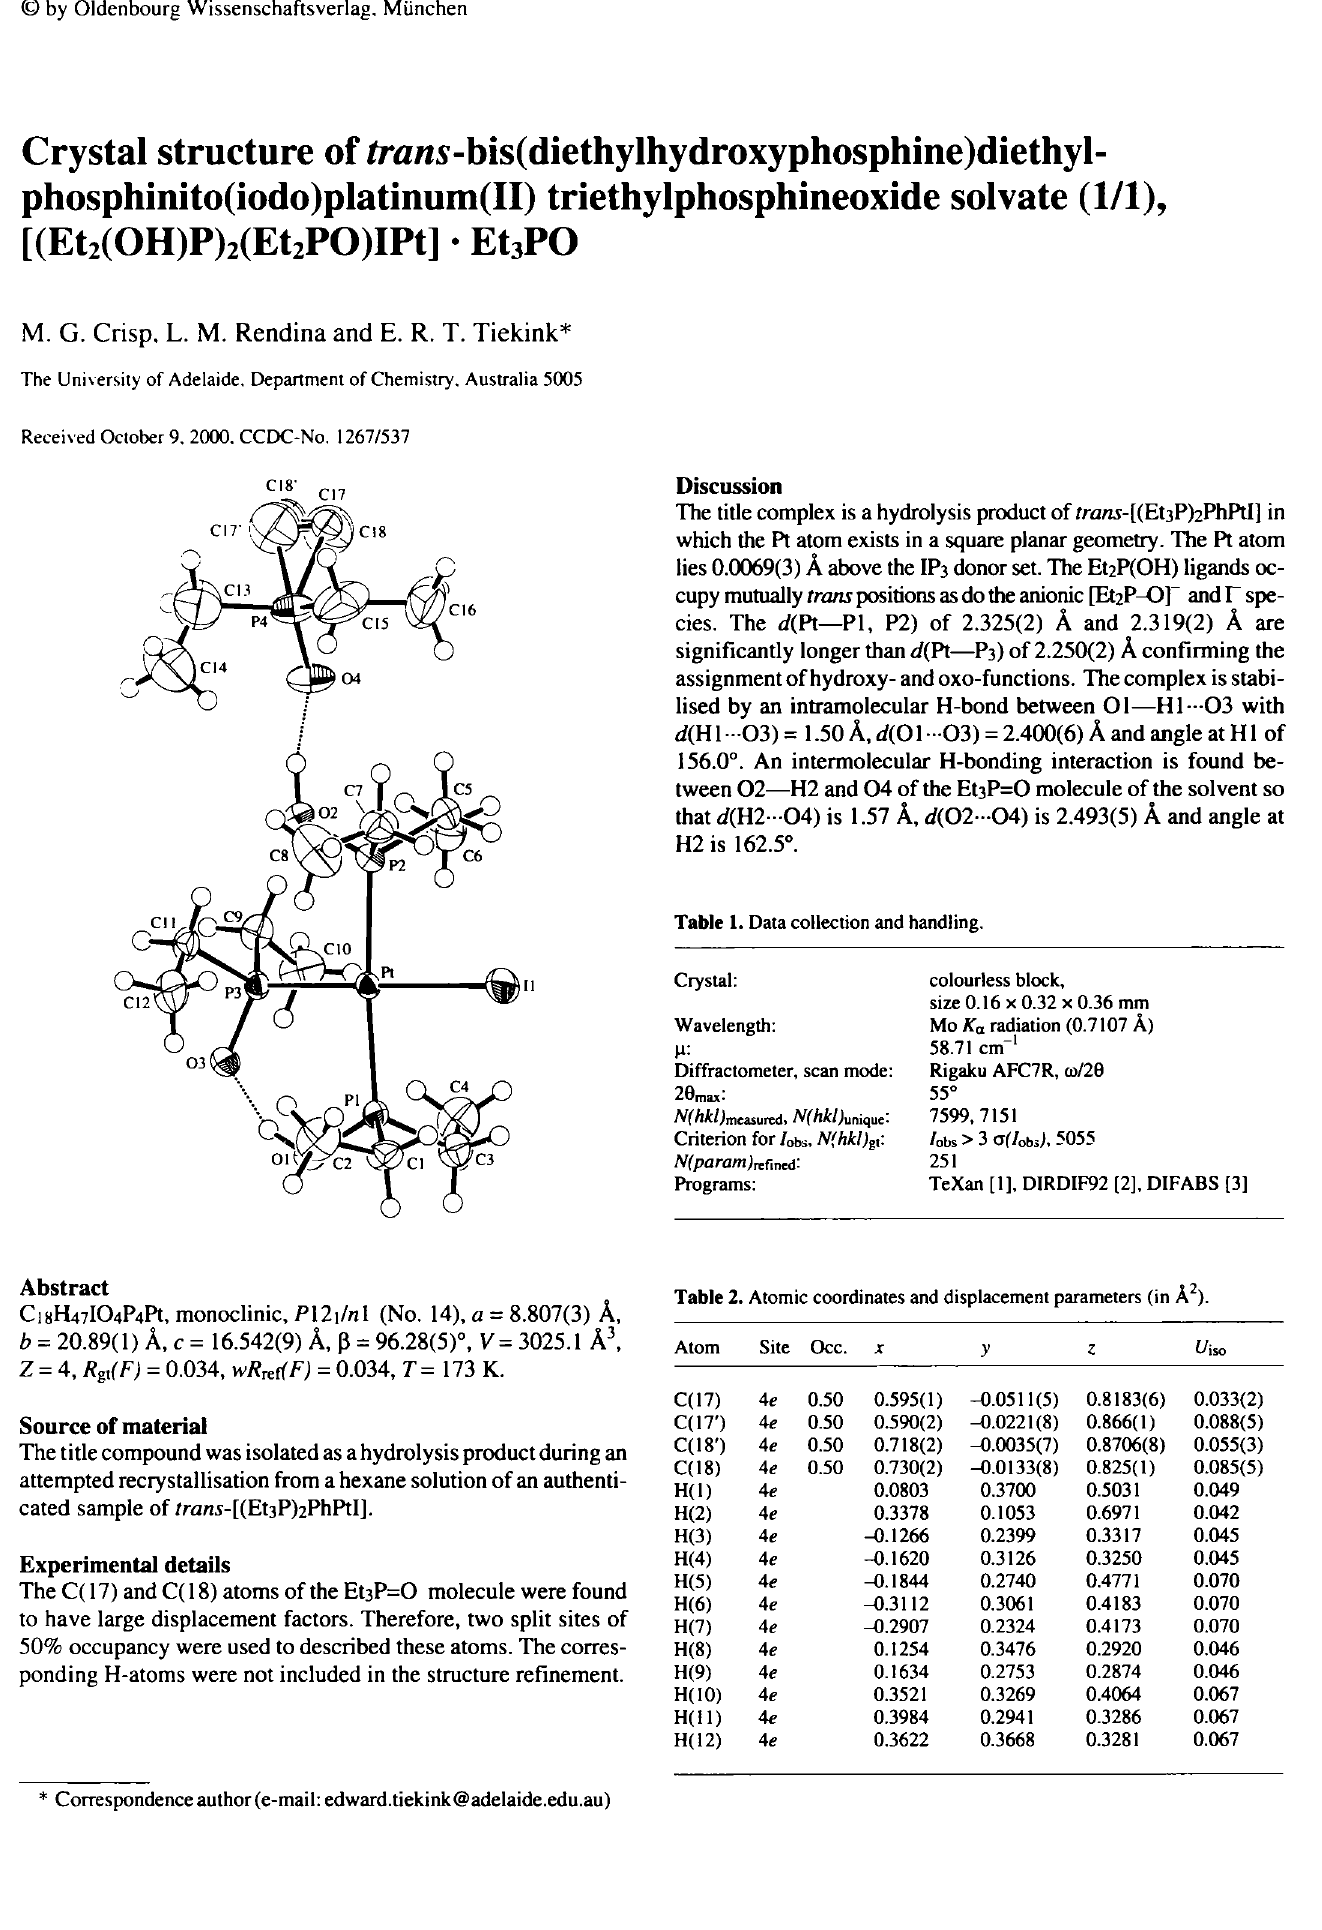
Table 2. Atomic coordinates and displacement parameters (in A 2